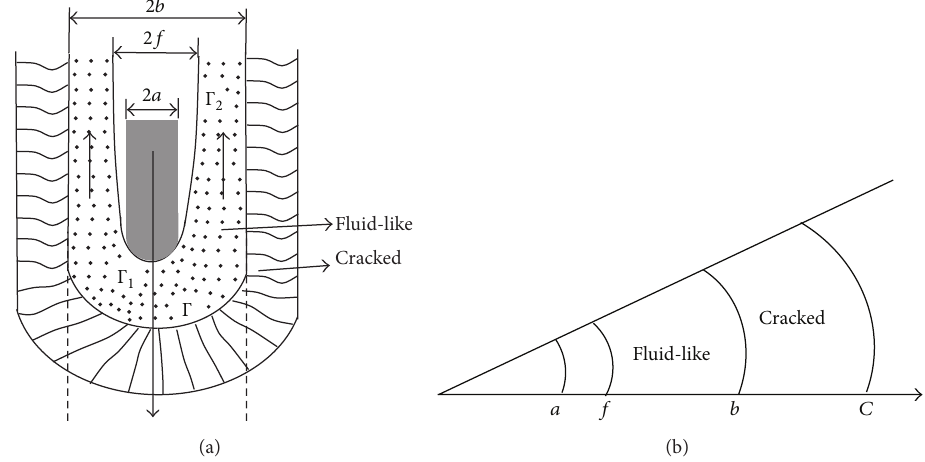
Figure 13: High velocity projectile penetrating concrete target.